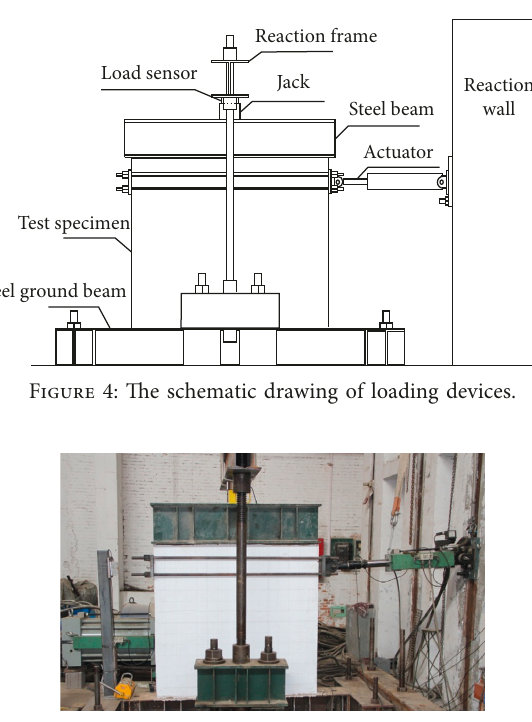
Figure 5: The picture of test setup.